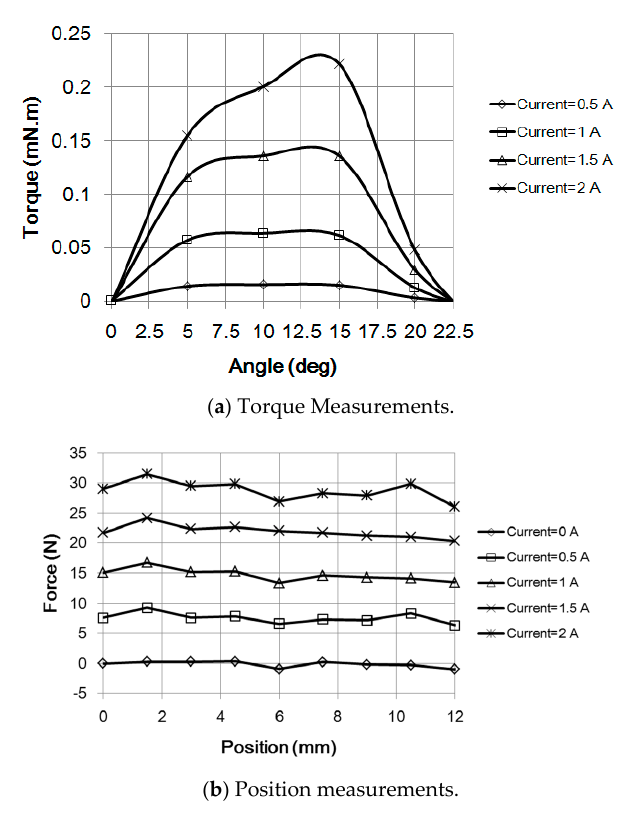
Figure 14. Mechanical parts of the motor and experimental setup.